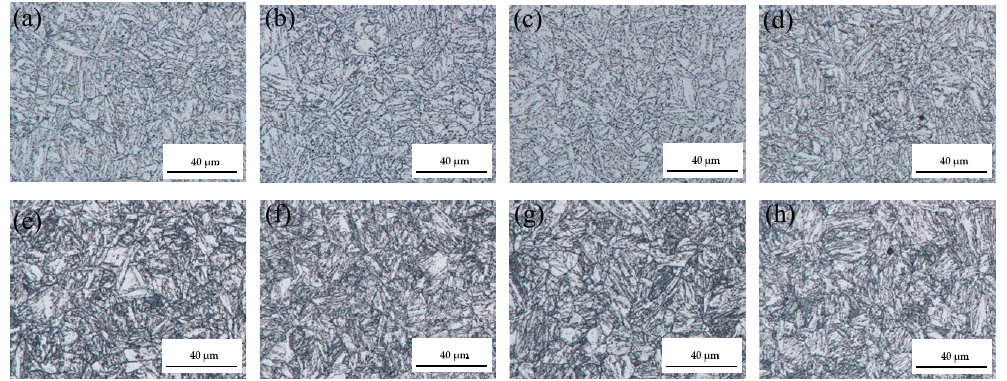
Figure 2. Microstructure of aged samples: ( a – d ) 1500 h, ( e – h ) 3000 h, ( a , e ) 0Y, ( b , f ) 6Y, ( c , g ) 36Y, and ( d , h ) 71Y. Table 2. Average prior grain sizes (APGZ) of the aged alloys ( μ m).